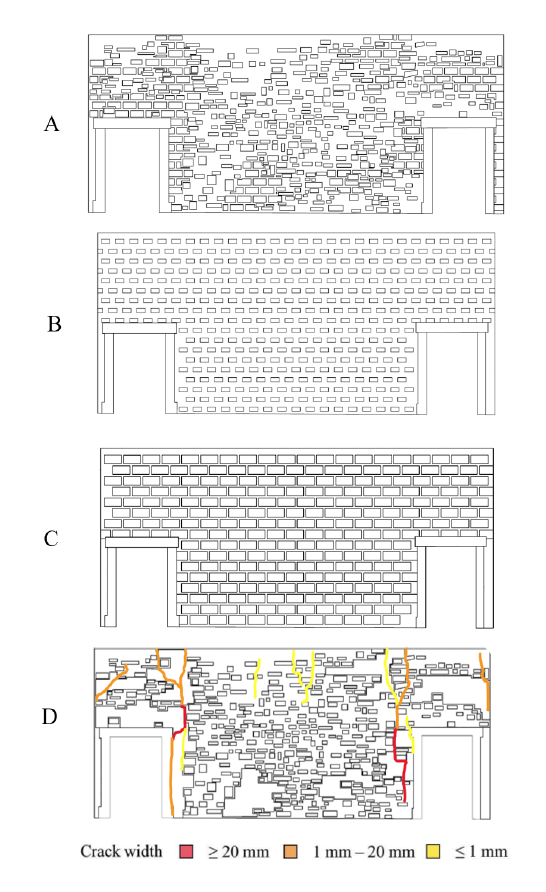
Figure 7. A) Existing geometry of the wall, B) Semi-Idealized geometry, C) Idealized geometry, D) Crack map. Figures adapted from (Napolitano et al.,